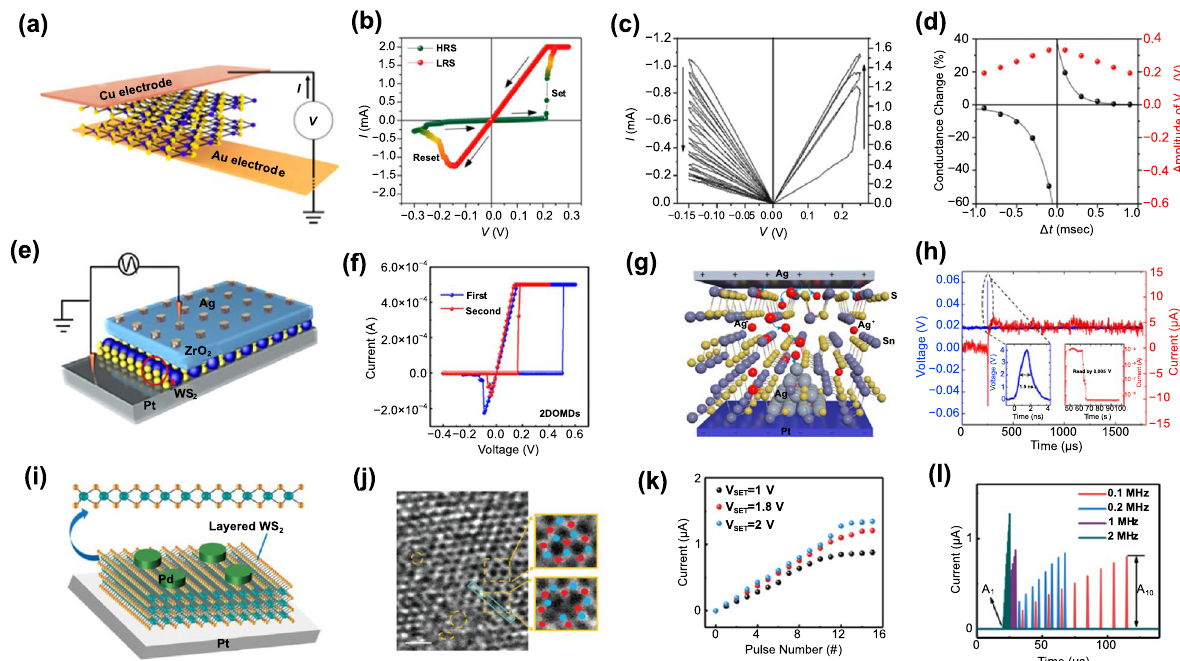
Fig. 30 2D materials-based artificial synapse. a CF formation in Cu/ MoS 2 /Au-based RRAM. b I–V resistive switching characteristics and c switching characteristics of artificial synapse. d Depiction of STDP Behaviour. Reproduced with permission from [357]. Copyright 2019 Nano Letters. e Schematic of Ag/ ZrO 2 / WS 2 /Pt-based RRAM, f I–V curve of Ag/ ZrO 2 / WS 2 /Pt-based RRAM. Reproduced with permission from [358]. Copyright 2019, American Chemical Society. g Depiction of ion dynamics in Ag/SnS/Pt RRAM. h Demonstration of faster switching times with 4 V/1.5 ns voltage pulse. Reproduced with permission from [359]. Copyright 2021, Nano Letters. i Atomic vacancy formation and migra- tion in Pd/ WS 2 /Pt RRAM device. j TEM image of the RRAM device in the LRS. k Pulse modulation of the device obtained by varying amplitude of the input voltage. l Current response for the train of pulses with varying frequencies. Reproduced with permission from [360]. Copyright 2019